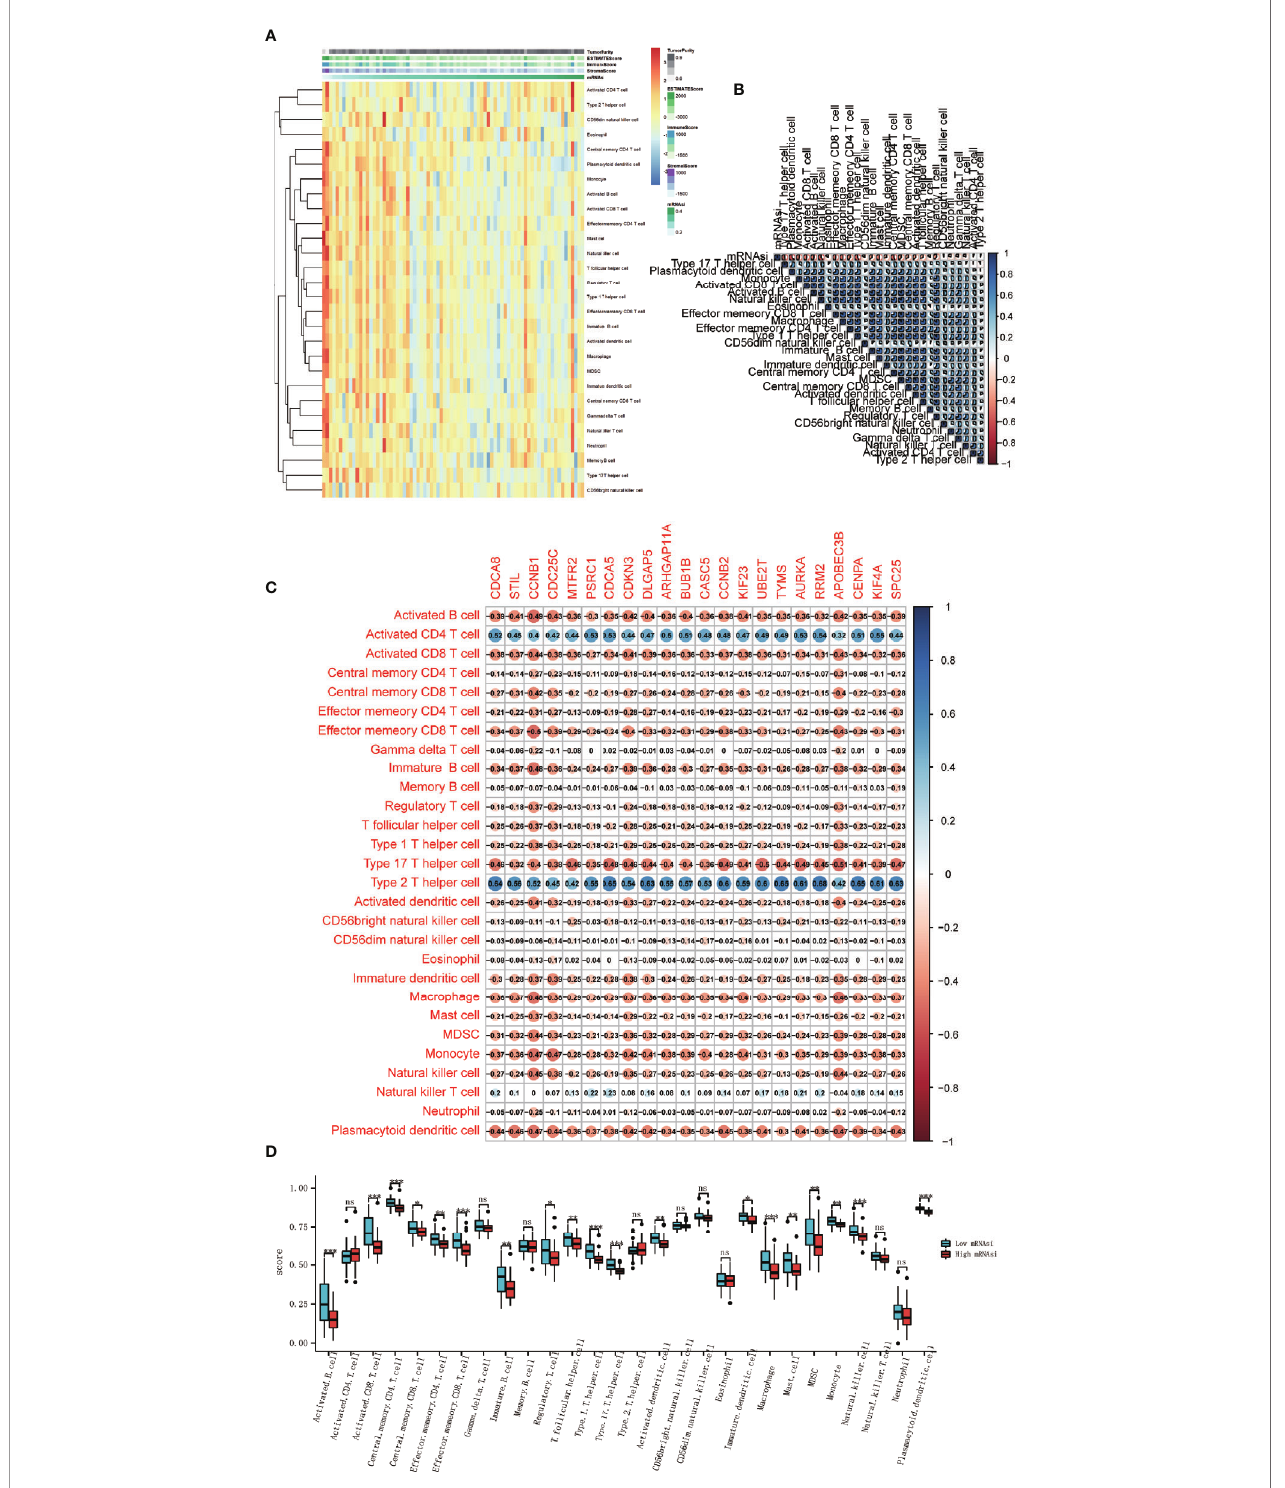
FIGURE 6 | Association between immune cell in fi ltration and cancer stemness. (A) Heatmap of the ssGSEA score calculated by immune cell gene sets. (B) Correlation analysis between 28 immune cells and mRNAsi score. (C) Correlation analysis between 28 immune cells and 22 stemness-related hub genes. (D) Boxplot of the differential analysis of 28 immune cells ’ in fi ltration between high-mRNAsi and low-mRNAsi groups (*P < 0.05, **P < 0.01, ***P < 0.001, ns, not signi fi